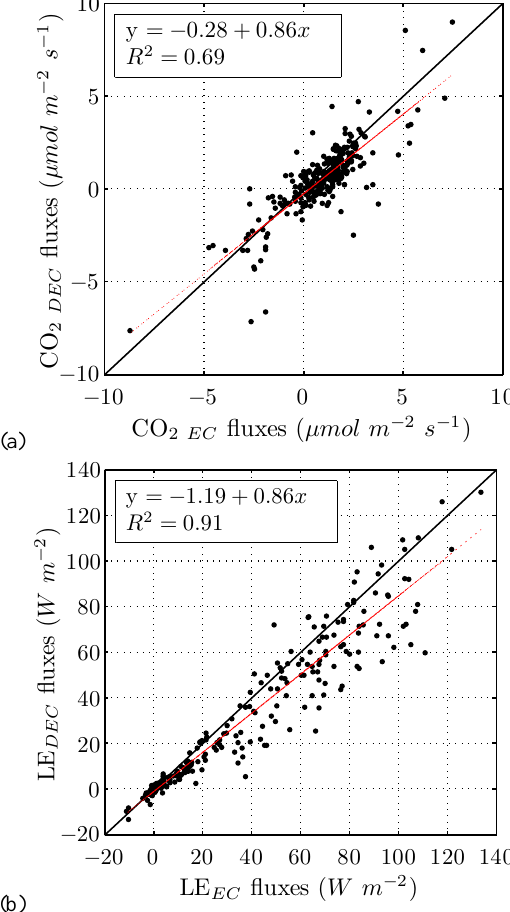
Fig. 10. Same as Fig. 8, but for “real” DEC instead of simulated DEC